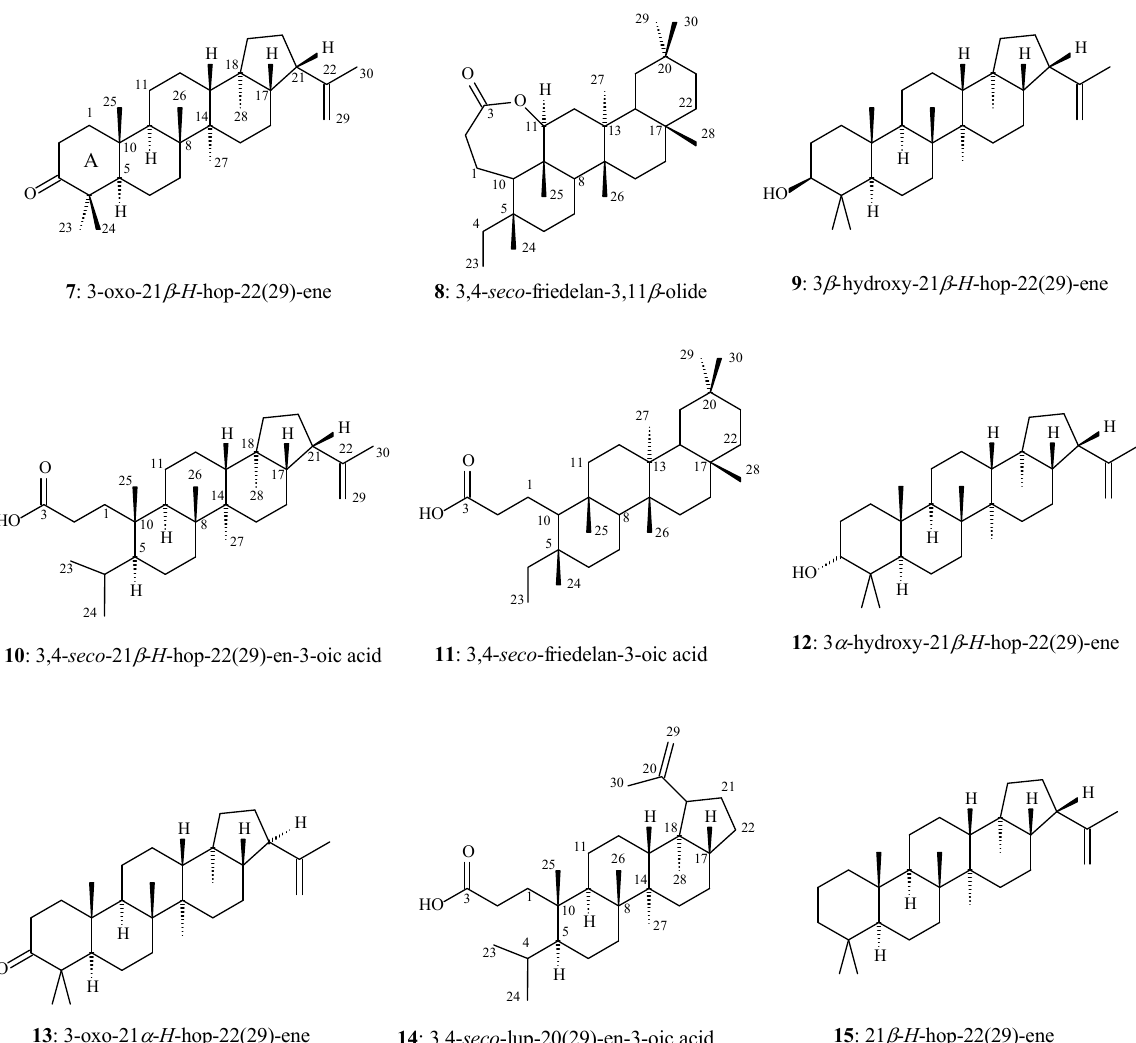
Figure 2. Chemical structure of triterpenes isolated from the leaves of M. robusta (compounds 7 to 11 ), including similar chemical structures of triterpenes (compounds 12 to 15 ) with NMR data described in the